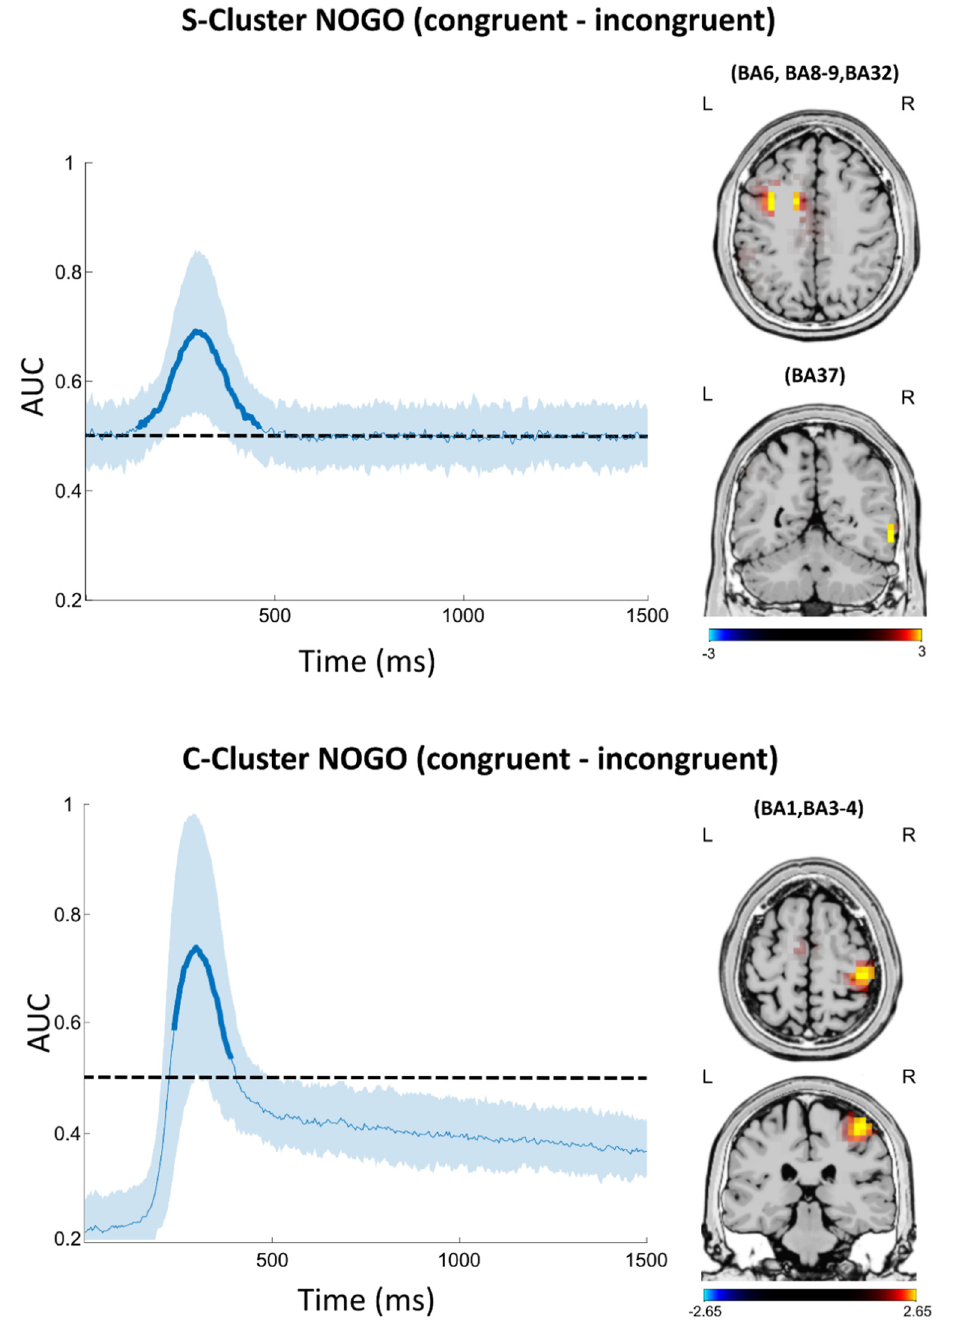
Figure 5. MVPA classification results show the area under the curve (AUC) decoding accuracy across time for all subjects for RIDE data in the S-Cluster ( top left ) and C-Cluster ( bottom left ). Time point zero denotes the onset of target stimulus presentation. Thick lines indicate the significant time windows ( p < 0.05; two-sided cluster-based permutation). The dashed line indicates the chance level. Shaded error bars represent the standard deviation. Additional sLORETA-derived maps indicate the sources of maximal differences between congruent and incongruent Nogo trials in the highlighted time windows showing above-chance level classification performance for S-Cluster ( top right ) and C cluster ( bottom right ). Positive values indicate larger activation in congruent Nogo trials, while negative values indicate larger activation for congruent Nogo